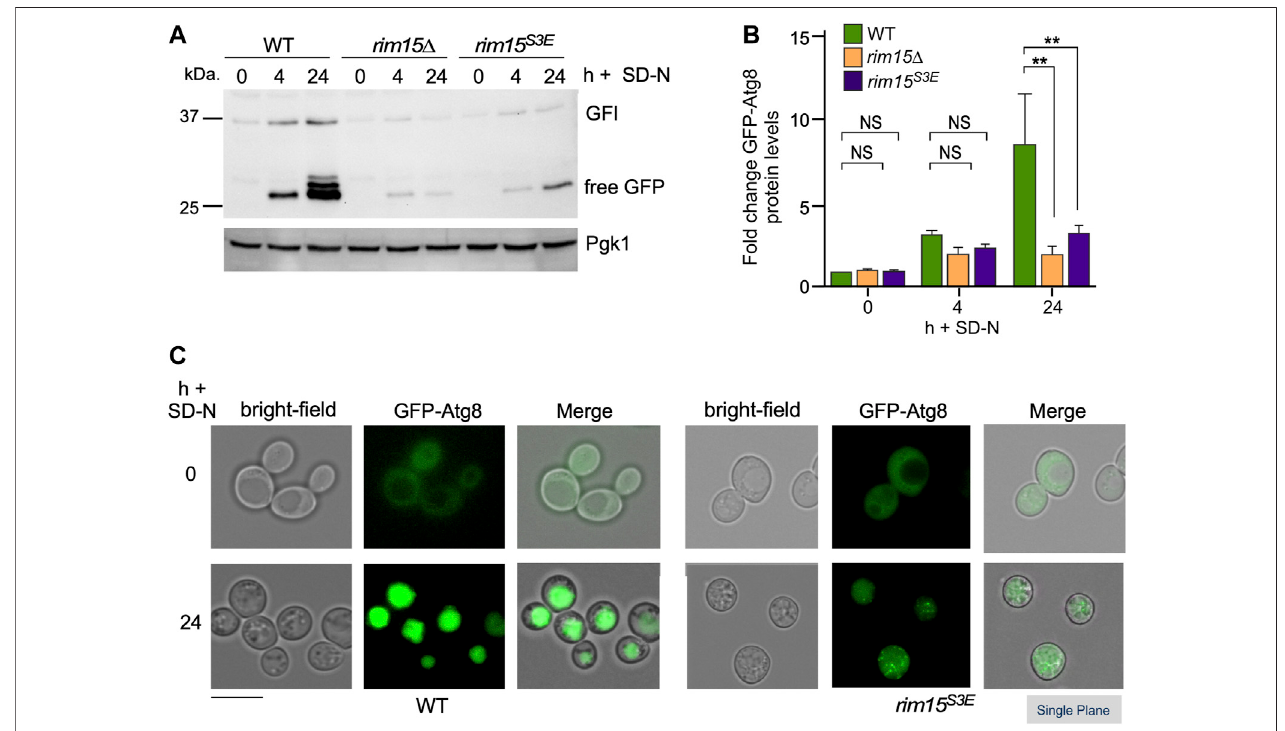
FIGURE8| TheautophagicdegradationofGFP-Atg8issigni fi cantlydecreasedin rim15 S3E . (A) GFP-Atg8cleavageassaysinthestrainsshown.Pgk1wasusedas a loading control. (B) Quanti fi cation ofGFP-Atg8induction observed in (A) , 4 h after nitrogen starvation. N =3. NS p ≥ 0.05; ** p ≤ 0.01. (C) Fluorescence microscopyof GFP-Atg8 before and 24 h after nitrogen starvation in pep4 Δ and pep4 Δ rim15 S3E . Representative single plane images are shown. Scale bar: 5 µm.